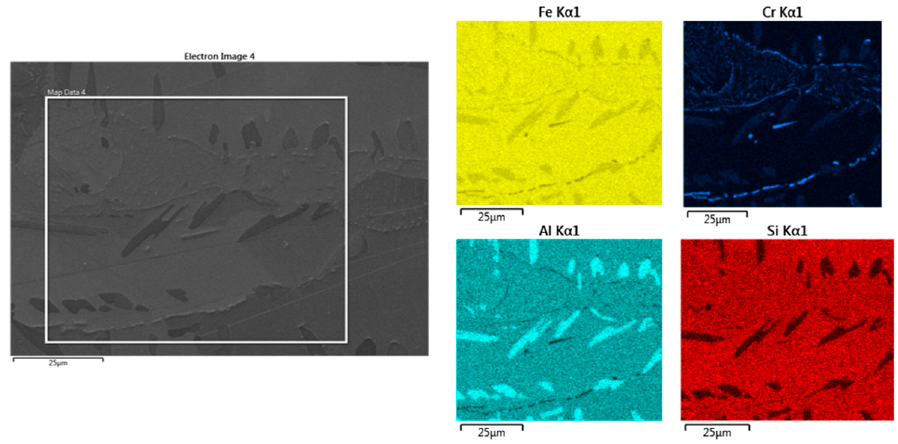
Figure 20. EDS analysis of the heat with 7 wt% Al.